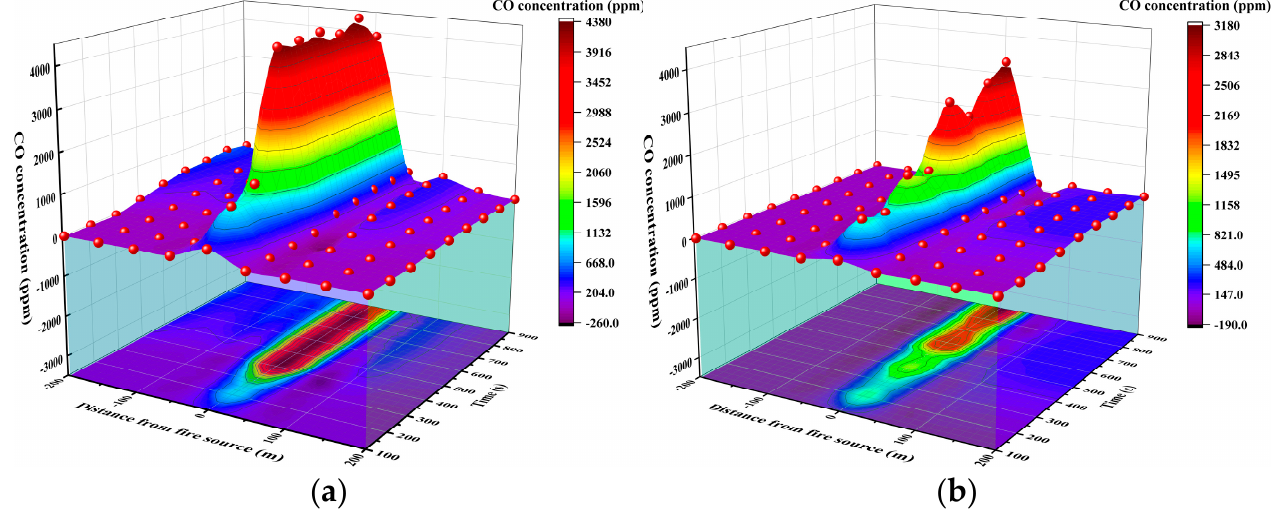
Figure 9. 3D curves of CO concentrations with time and distances: ( a ) 0.5 m/s; ( b ) 3.6 m/s.